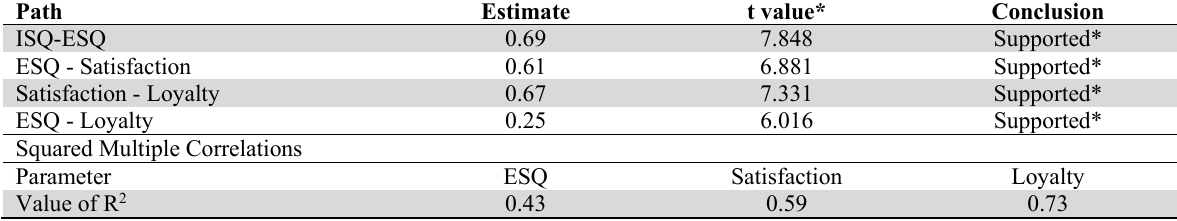
Results for Structural Relationship in the